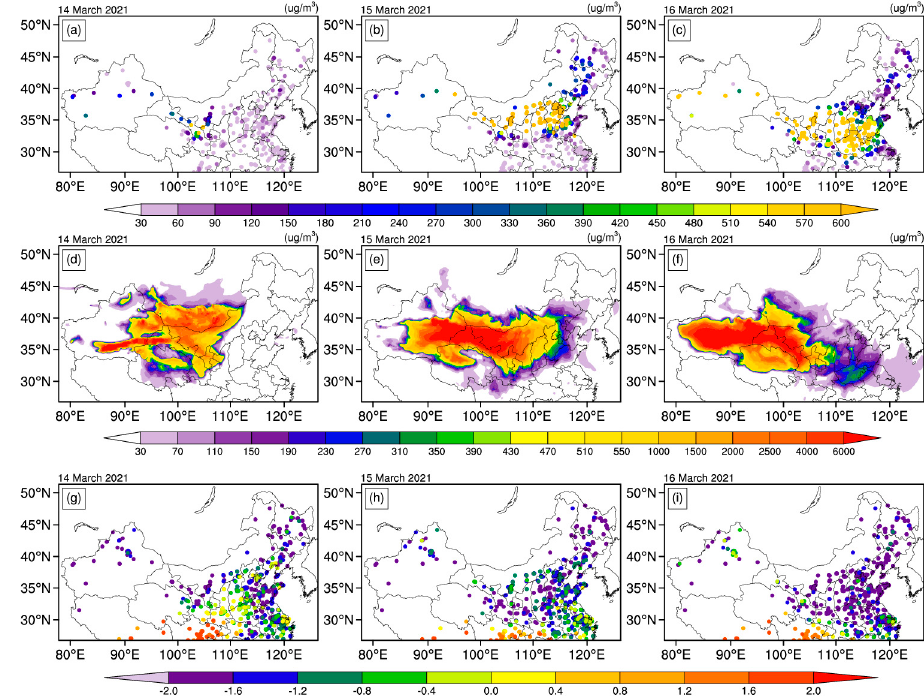
Figure 6. Spatial distributions of daily mean coarse mode particle surface mass concentrations (PM 10 minus PM 2.5 , units: µ g/m 3 ) from CNEMC ( a – c ) and WRF-Chem simulations ( d – f ) and mean fractional bias ( g – i ) on 14–16 March 2021.